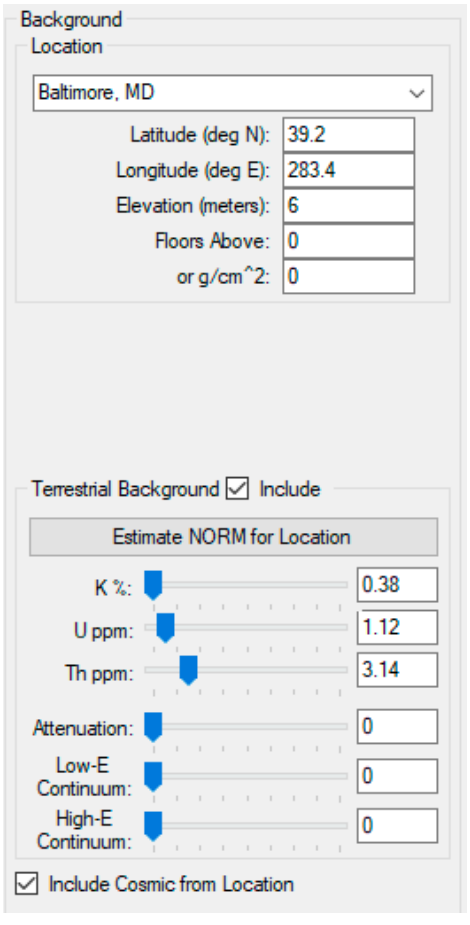
Figure 5. GADRAS Inject tool settings for generating background spectrum with NaI detector @ 122 cm, H = 56 cm (Baltimore, MD location is used, and terrestrial and cosmic are included). It is worth mentioning that for each emulated mixture foreground gamma ray spec- a paired background gamma ray spectrum using the background settings in Figure 5. Since inject text files for each mixture combination using an automated Matlab script and then used GADRAS’s “Run Batch” command which used these inject text files in a loop to